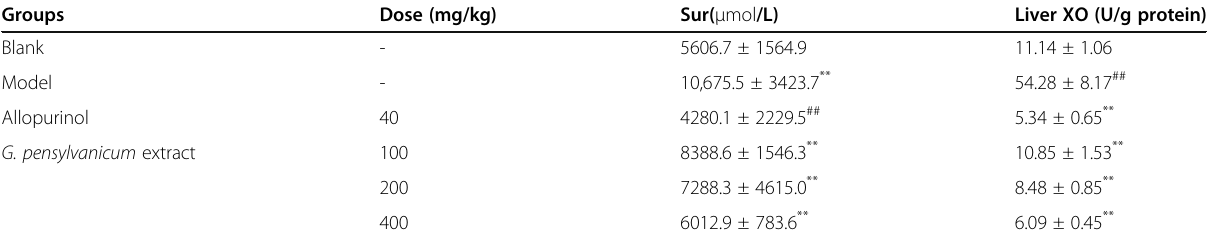
Table 2 Effects of G. pensylvanicum and Allopurinol on Sur and XO active in Liver of PO-Induced Hyperuricemic Mice Groups